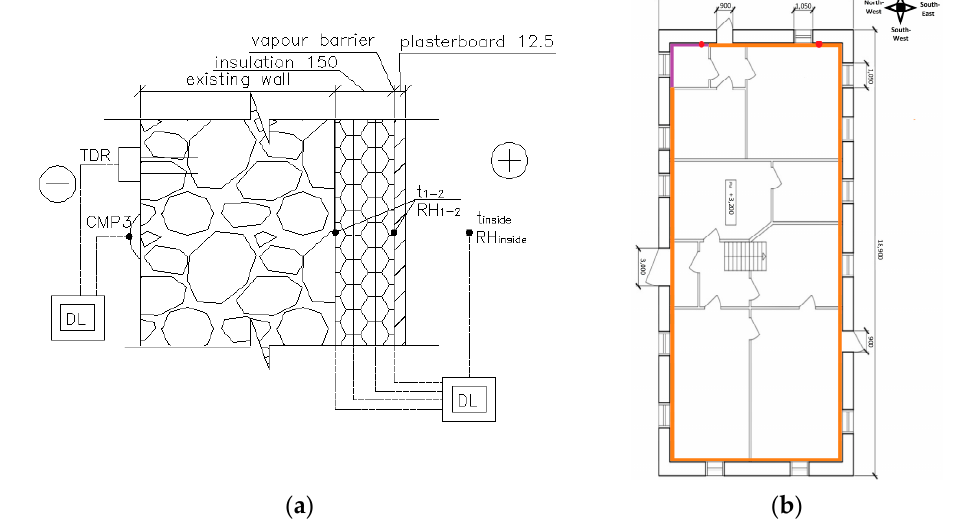
Figure 6. ( a ) Measurement setup (t—temperature; RH—relative humidity; CMP3—sun radiation, DL—data logger, TDR—volumetric water content.); ( b ) Measurement points: heat flow, temperature, and relative humidity sensors in the walls (the red dots).